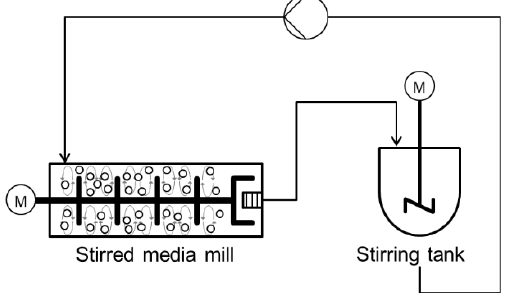
Figure 1. Milling setup for circuit mode operation used for the basic grinding investigations with quartz limestone mixtures and for the production of submicron silicon suspensions.